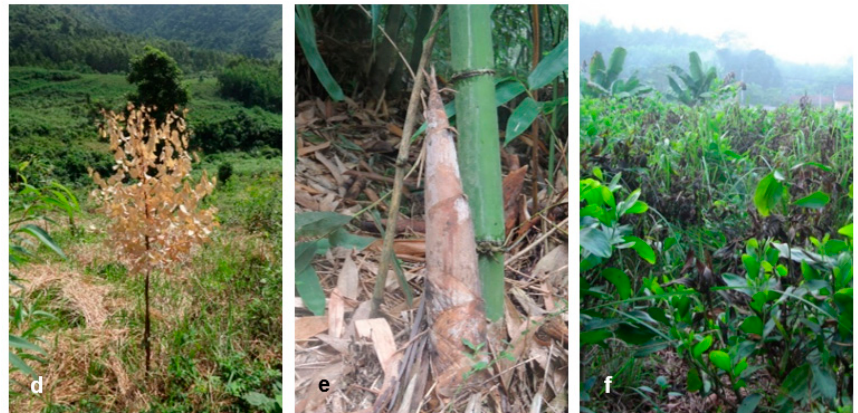
Figure 6. Pathogens damaging forest plantations and nurseries in Vietnam. ( a – d ) Ceratocystis manginecans wilt disease; ( a ) Acacia auriculiformis ; ( b ) Acacia hybrid; ( c ) A. mangium ; ( d ) Eucalyptus urophylla ; ( e ) Shoot rot in Dendrocalamus latiflorus caused by Fusarium solani ; ( f ) Decline in Acacia hybrid mother plants caused by Phytophthora acaciivora .